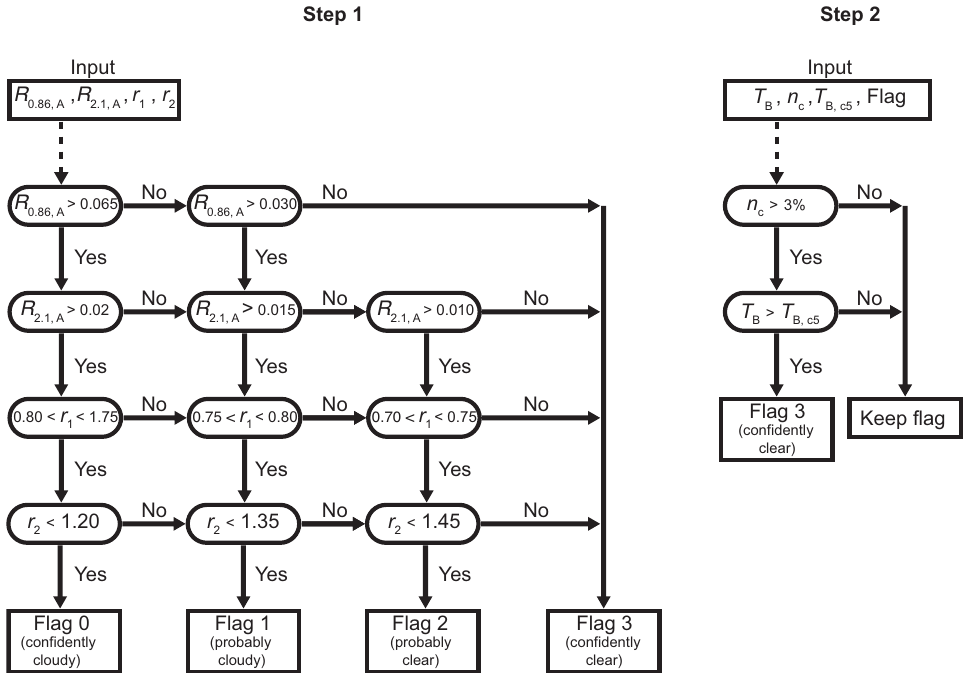
Figure 3. Outline of the new ASTER cloud mask algorithm. Step 1 illustrates the decision tree including cloudiness tests (i)–(iv) based on ASTER band 3N and 5 reflectances R 0 . 86 and R 2 . 1 , as well as color ratios r 1 and r 2 . The results of tests (i)–(iv) yield a designation of cloudiness flag “0” (confidently cloudy), “1” (probably cloudy), “2” (probably clear), or “3” (confidently clear) for each pixel. Step 2 illustrates the correction for complex broken cumulus scenes, as well as cases with pronounced sunglint. This correction, test (v), is based on the derived cloudiness flags from step 1, the brightness temperature T B , 11 (calculated from the ASTER band 14 radiances), the percentage of clear pixels with cloudiness flag “3” ( n c ), and the 5th percentile of T B , 11 sampled over all clear pixels ( T B , c5